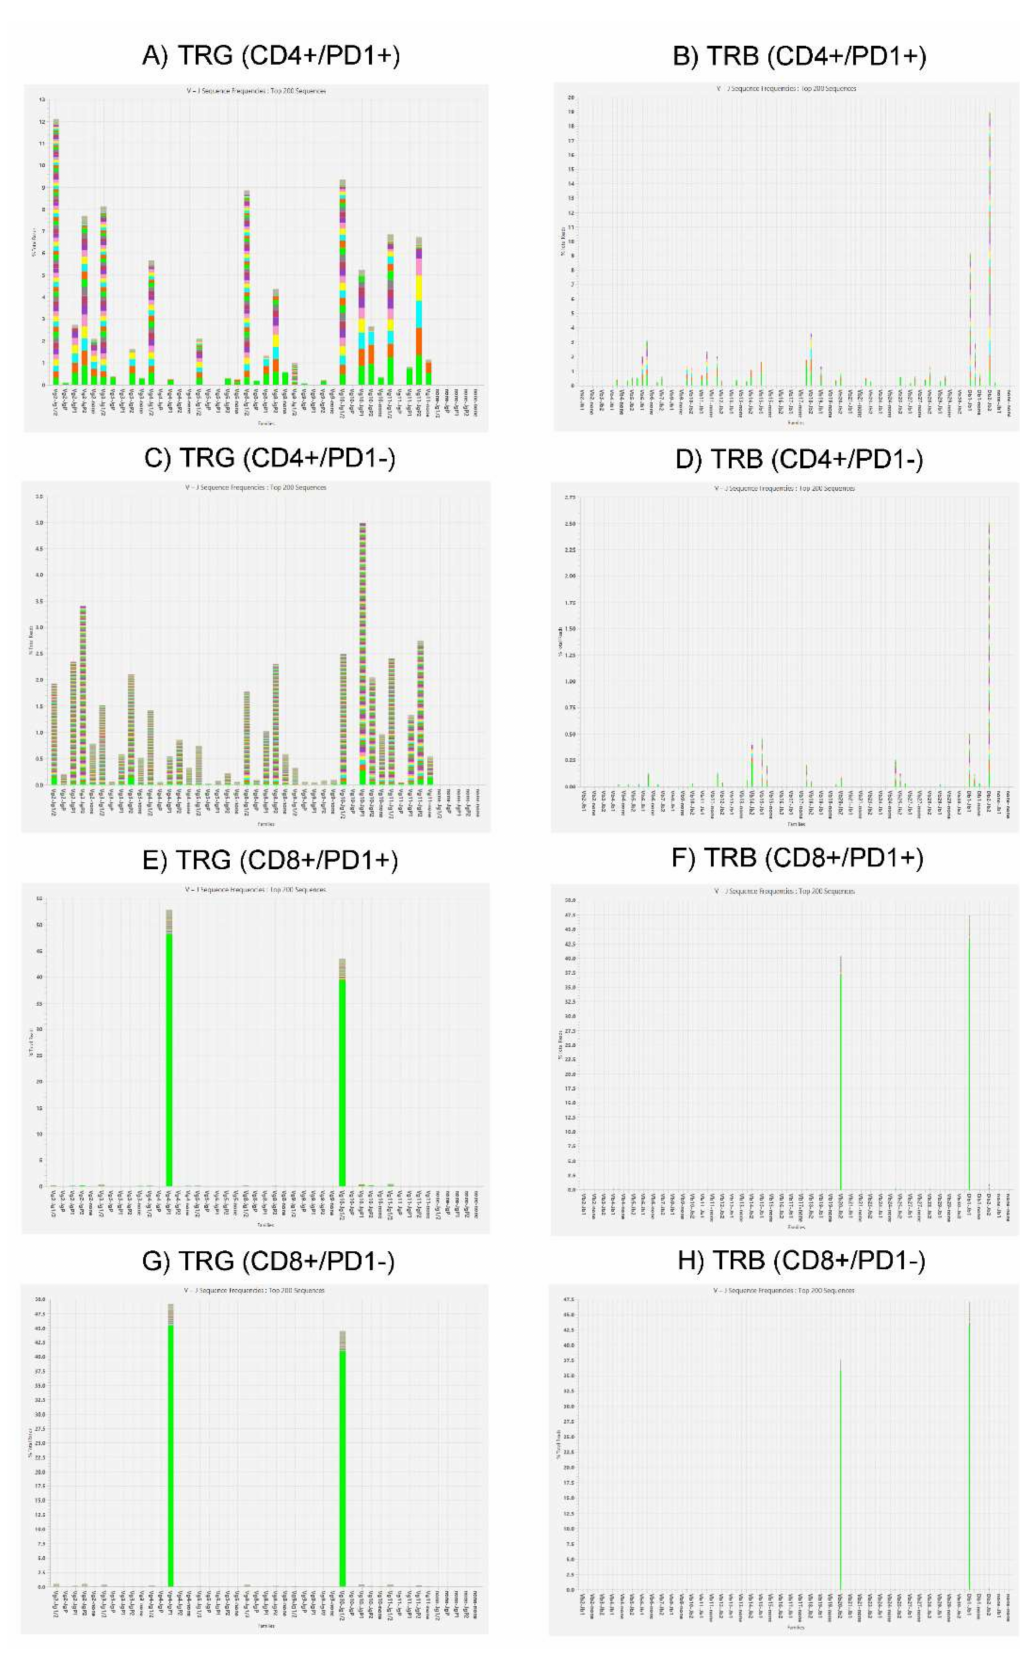
Figure 5. T-cell receptor clonality studies on 4 cell-sorted populations by next-generation sequencing